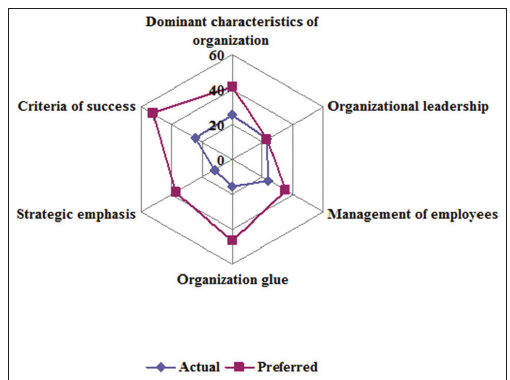
FIGURE 4. The key dimensions of the clan culture in PHC center B – actual and